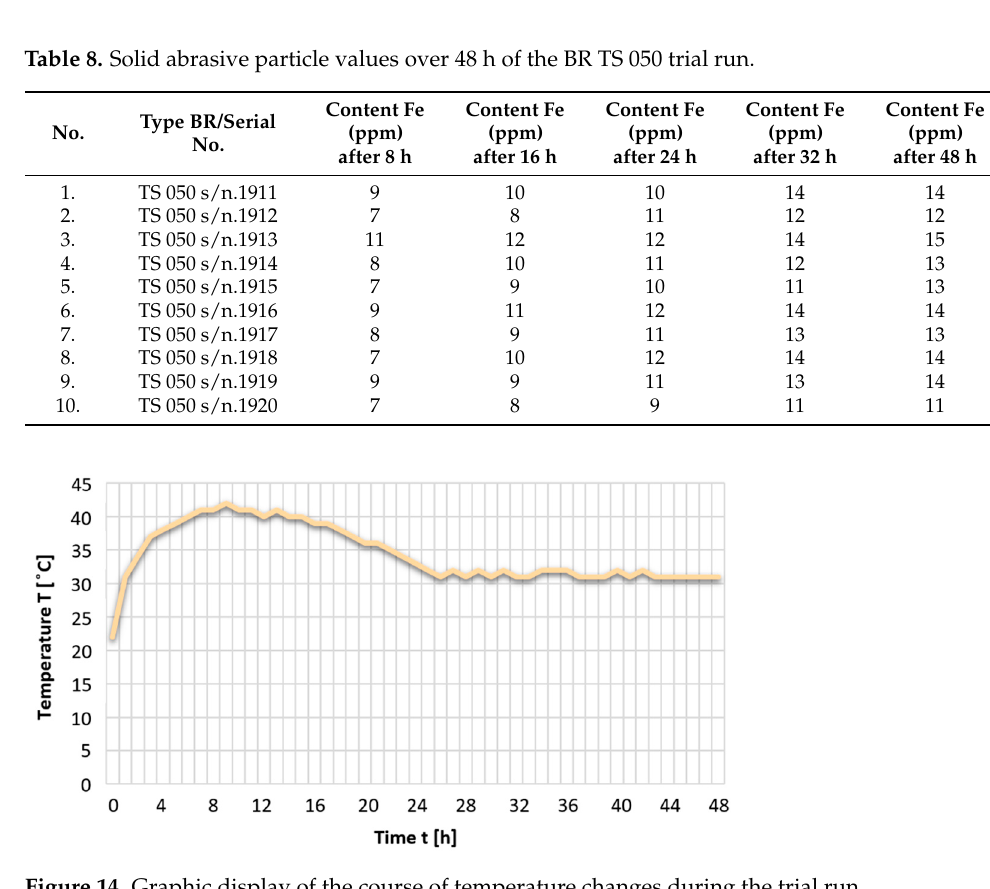
Table 8. Solid abrasive particle values over 48 h of the BR TS 050 trial run.